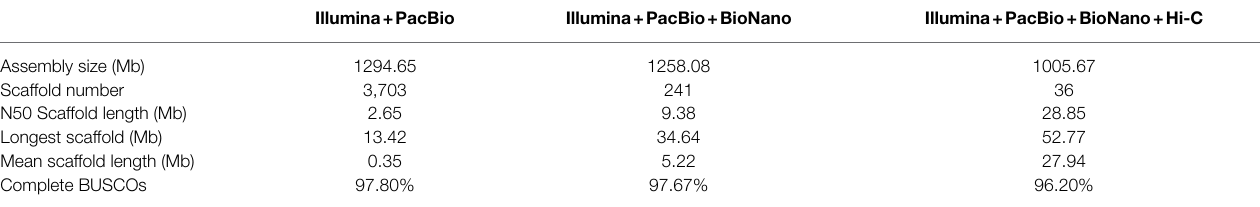
TABLE 1 | Statistics of Cynodon dactylon genome